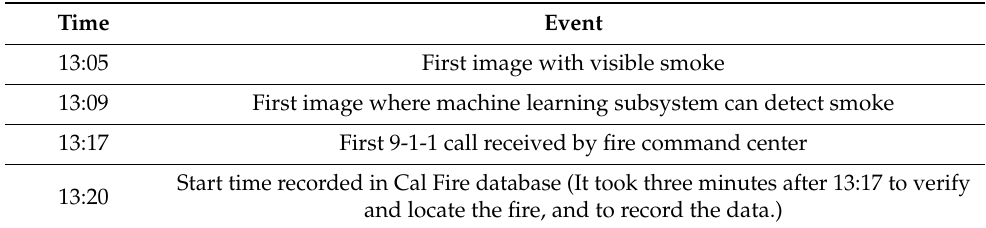
Table 2. Timing data for 2018 Holy Fire.